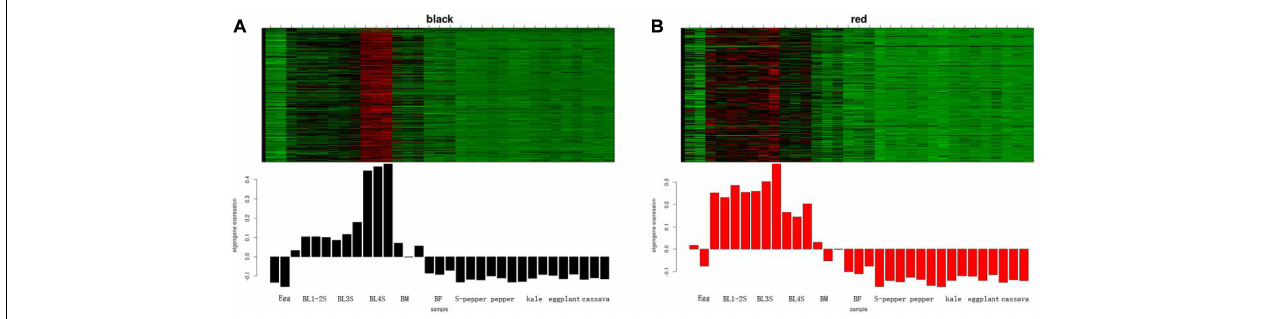
FIGURE 3 | The development-related module of whitefly is performed by WGCNA. (A) The heatmap of expression pattern of genes in black module. (B) The heatmap of expression pattern of genes in red module. TABLE 1 | Evolutionary selection pressure of key modules related to host plant selection and development of the whitefly. Module Number of Number of Max of ka/ks Min of ka/ks Average of ka/ks Proportion of ka/ks > 1 co-expressed genes with genes ka/ks > 1 Host plant-related Midnight blue 87 2 1.2207 0.001 0.289 0.036 Turquoise 3433 74 99 0.001 0.281 0.057 Magenta 293 12 99 0.001 0.308 0.030 Development-related Black 911 8 99 0.001 0.261 0.013 Red 982 5 99 0.001 0.271